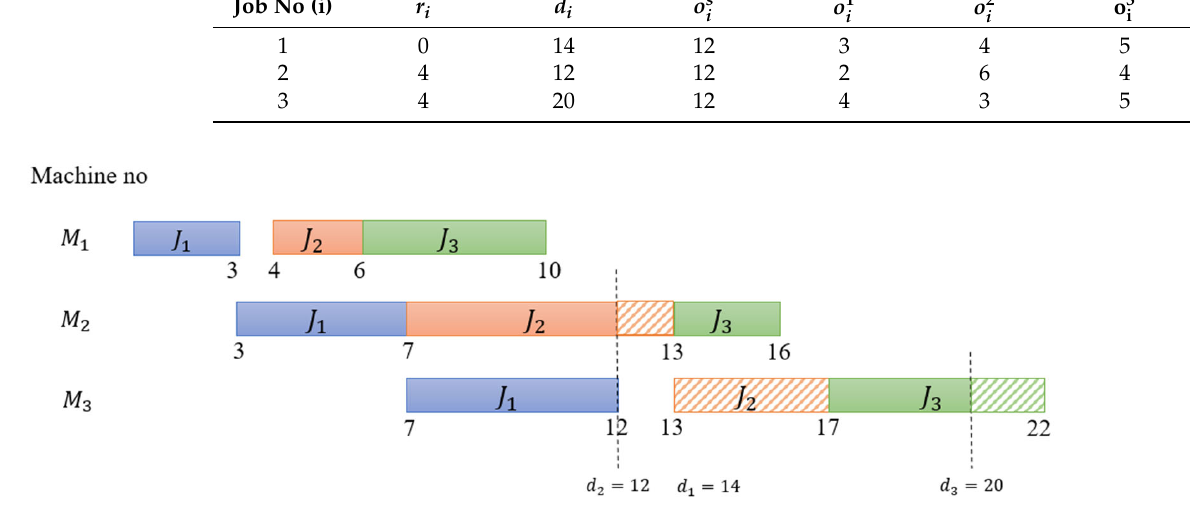
Figure 1. The Gantt chart with a job permutation of 1 ‐ 2 ‐ 3.